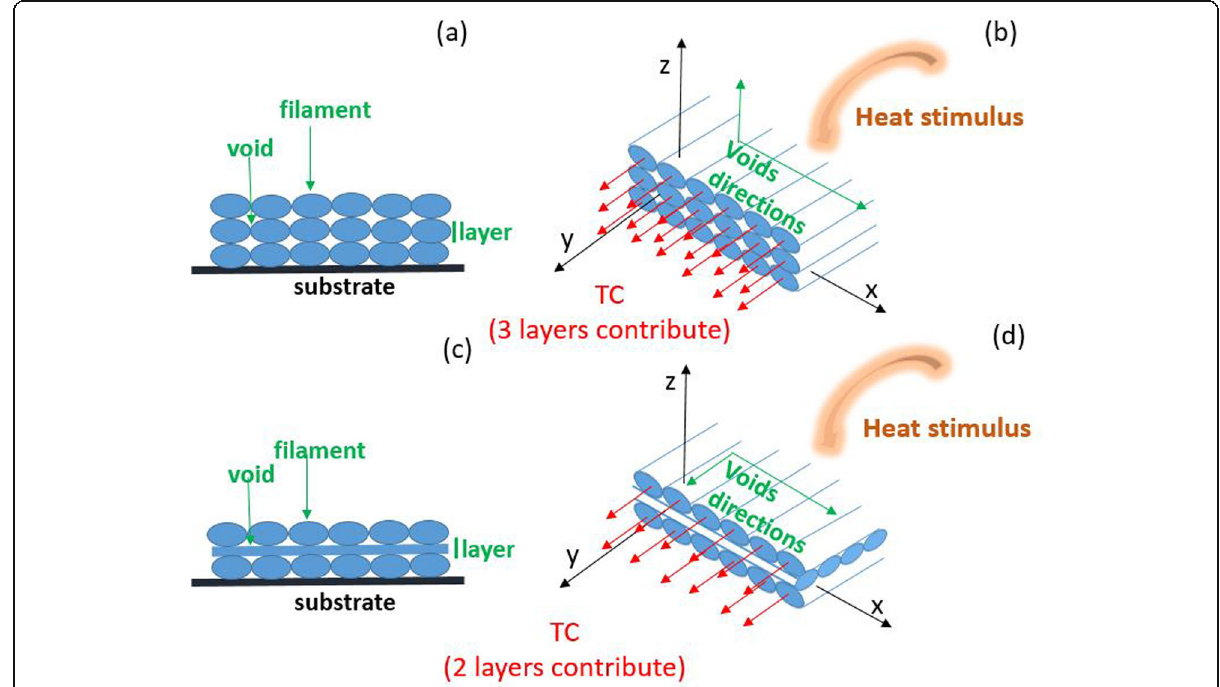
Fig. 2 Schematic diagram illustrating the effect of voids and printing direction on TC. a , b filaments printed with the same orientation generate voids perpendicularly arranged (x-z directions), with respect to the thermal conduction direction (y-direction) thus maximizing TC along the conductive axis (y-axis) and c , d , filaments printed in different orientations generate voids along the thermal conduction direction, thus reducing TC along the conductive axis (y-axis)